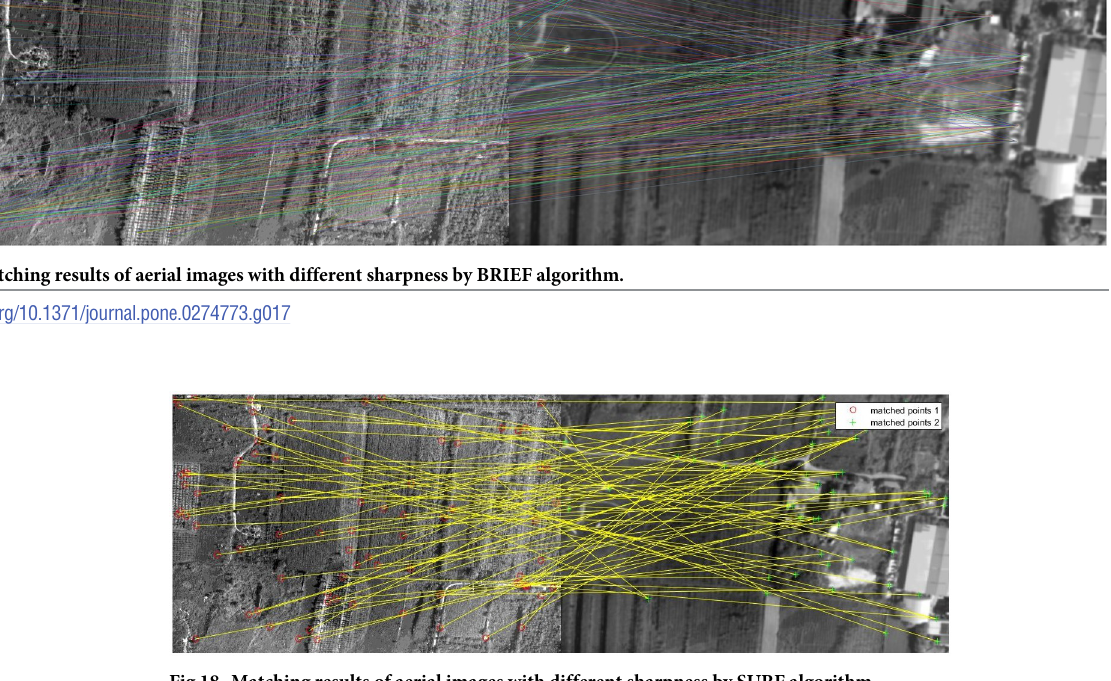
Fig 18. Matching results of aerial images with different sharpness by SURF